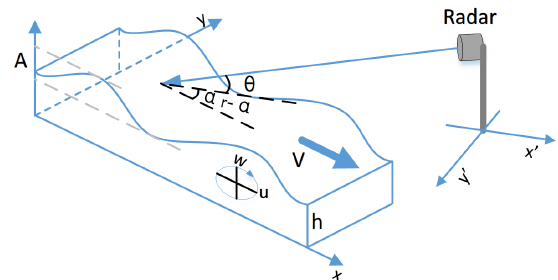
Figure 1. Schematic illustration of the radar measurement of surface wave